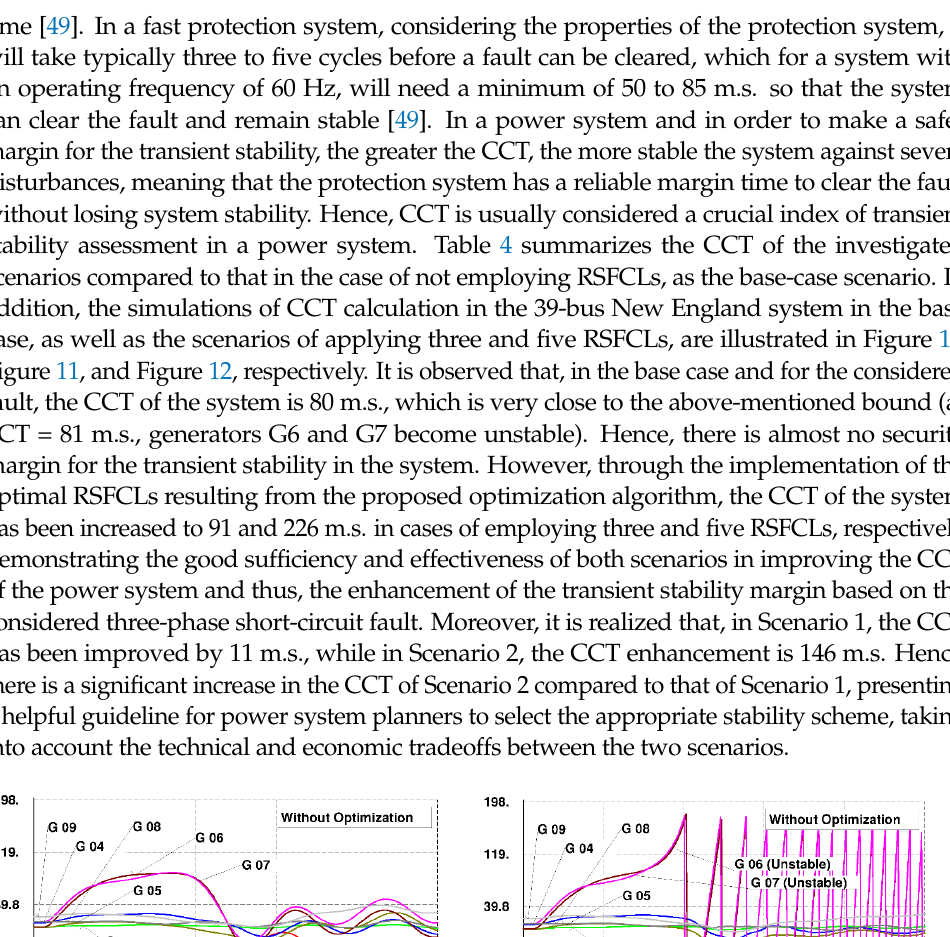
Table 4. CCT improvement in the investigated scenarios.